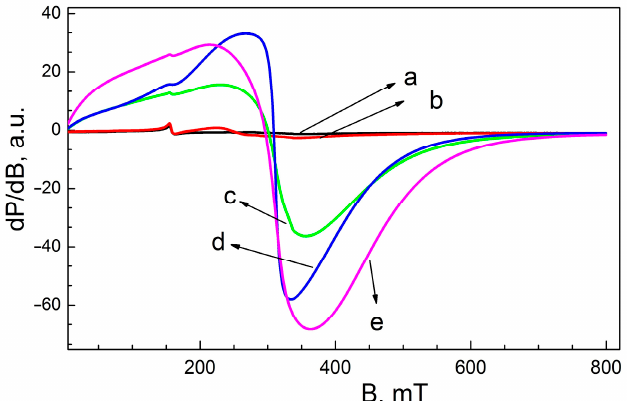
Figure 5. ex-situ EPR spectra of fresh Pd-LMO/Imp (a) and Pd-LMO/Imp reduced with CH 4 at 200 °C (b), 500 °C (c) and 700 °C (d). For the sake of comparison, the completely reduced Pd-LMO/Imp with H 2 at 700 °C is also shown (e).